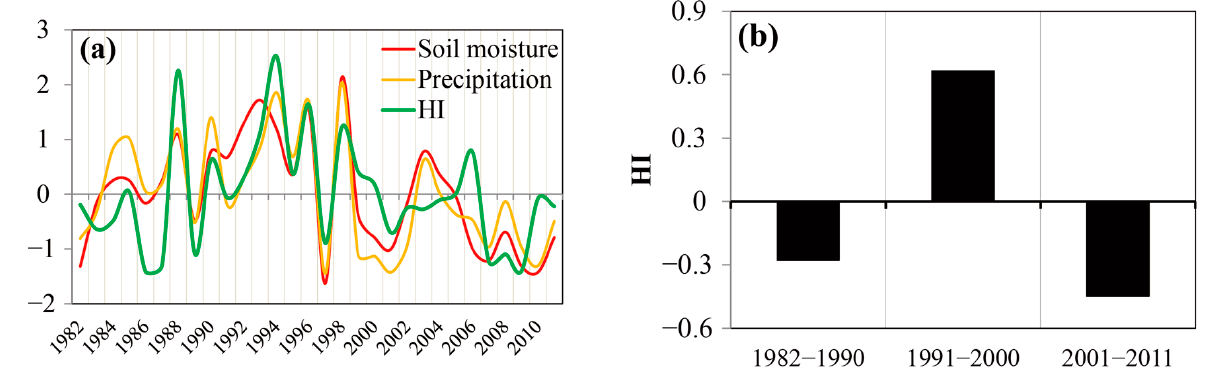
Figure 8. The variations in normalized regional-mean summer soil moisture, precipitation and Humidity Index (HI) during 1982–2011 in the NDPB in China on annual scale ( a ) and decadal scale ( b ). The HI is designed by Zeng and Zhang [27] to measure the summer monsoon intensity in NDPB, and higher HI indicates stronger summer monsoon.